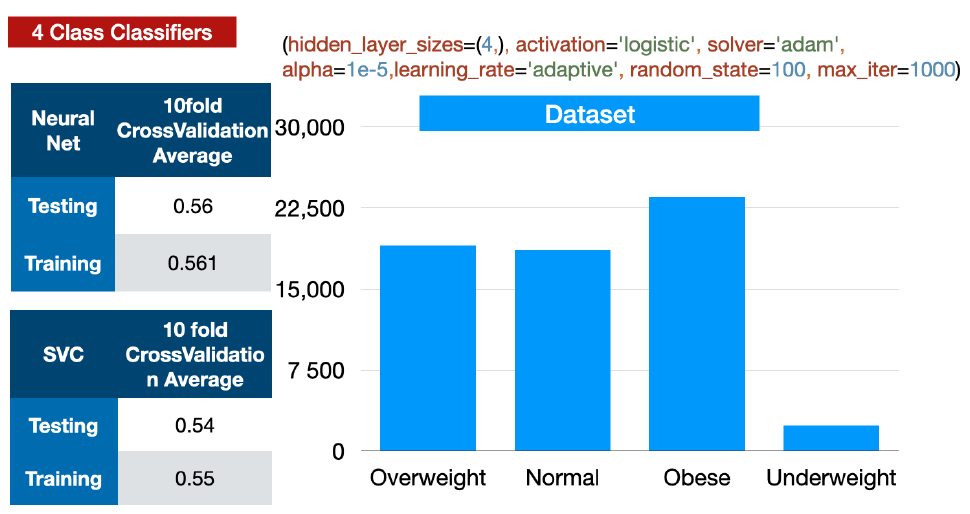
Figure 5. Four-class